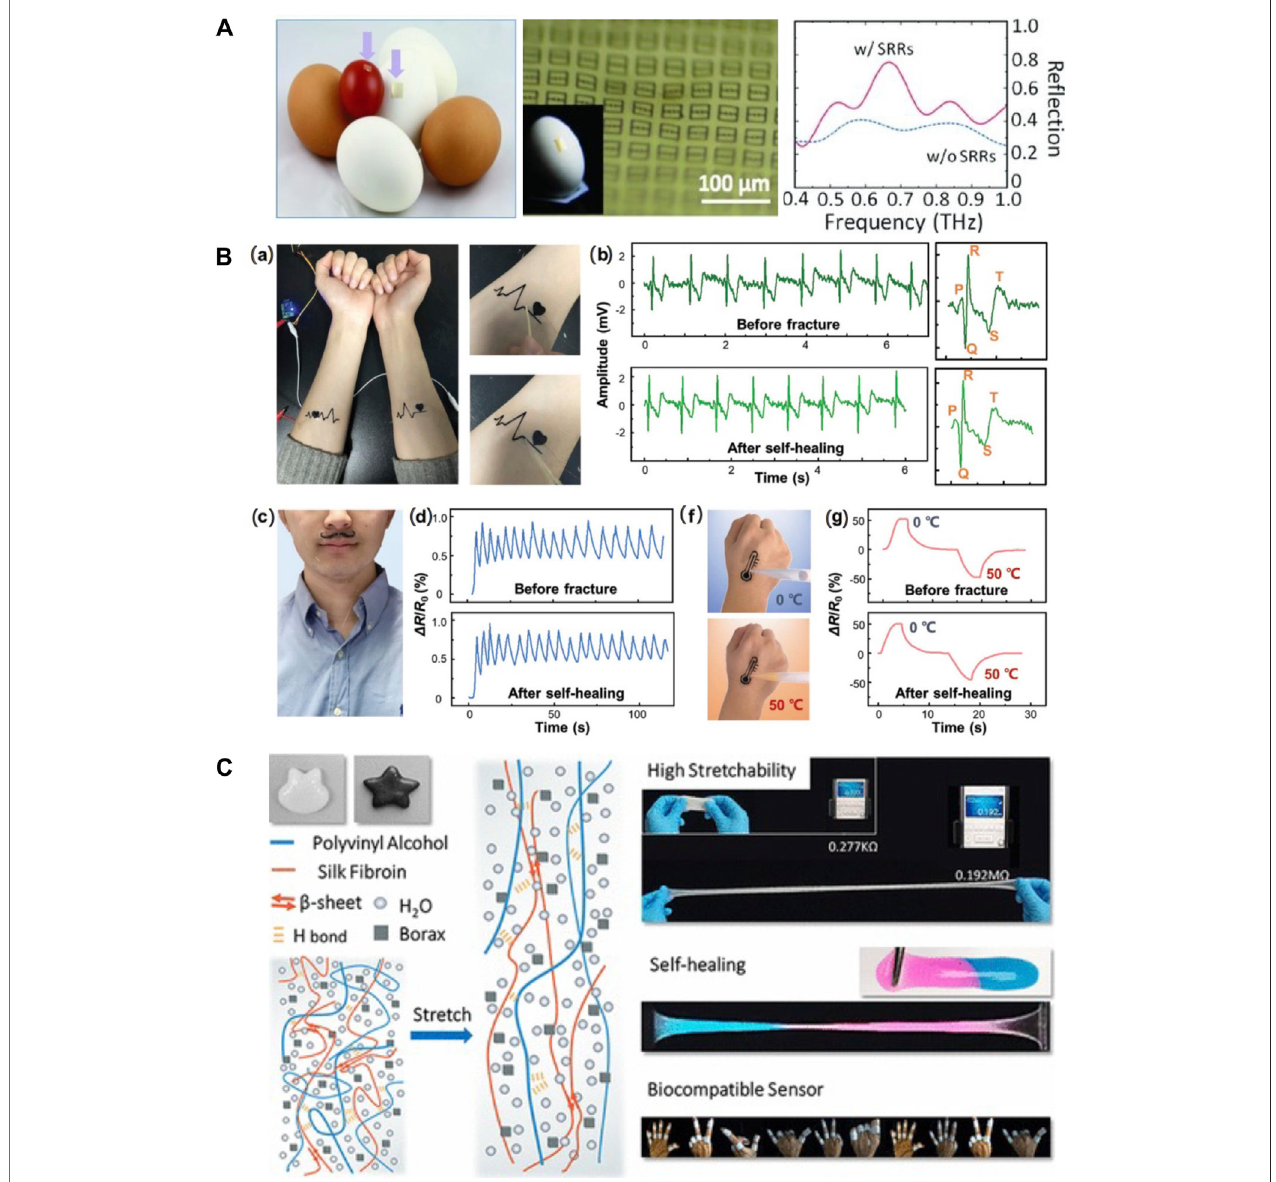
FIGURE 9 | Silk-based biomaterials in biosensor. (A) A conformal and adhesive silk-based food sensor was fabricated by printing an array of metamaterial antennas on the silk substrate. Adapted with permission from ref (Tao et al., 2012a). Copyright 2012 WILEY-VCH. (B) Self-healable multifunctional E-tattoos based on graphene/silk fi broin/Ca 2+ materials. (A) Flexible silk-based E-tattoos demonstrate robust attachment to the skin. The E-tattoos possess strong self-healing ability and can maintain their functions after the self-healing process for (B) ECG sensing, (C) respiration tracking, (D) humidity sensing, and (F – G) temperature sensing. Adapted withpermission from ref (Wang Q. et al., 2019). Copyright 2019 American Chemical Society. (C) Schematic propertiesand possible usagesof PVA/silk fi broin/ borax hydrogel. The interaction of β -sheet ensured its capacity of extensive stretch. The reintegration of hydrogen bonds facilitated the self-healing of the gel. These highly stretchable and self-healingPVA/silk fi broin/boraxhydrogelsexhibitapromising futureinbiocompatiblesensors. Adapted withpermission fromref(YangN.et al., 2019). Copyright 2019 WILEY-VCH.